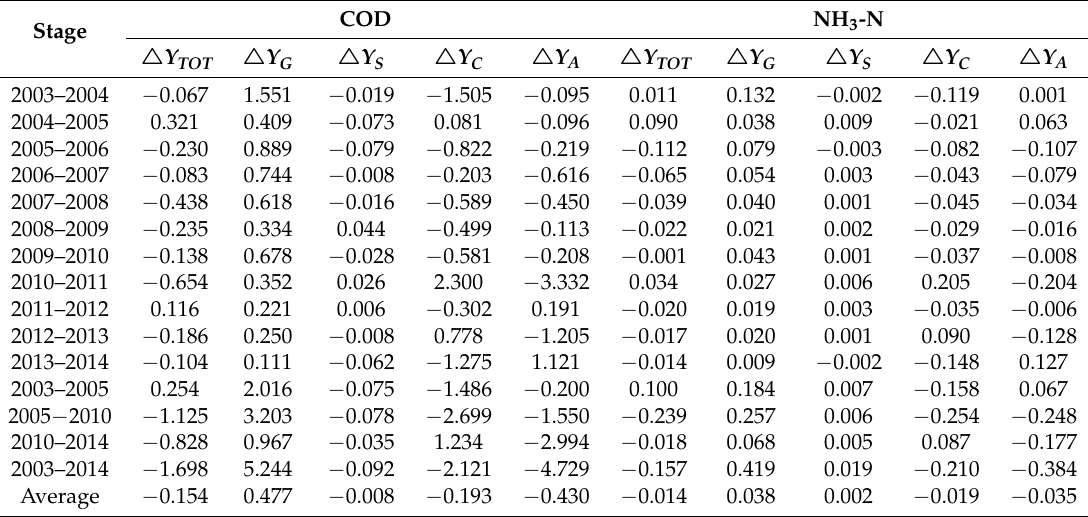
Table A3. Detailed additive decomposition results of COD and NH 3 -N changes (unit: Mt).